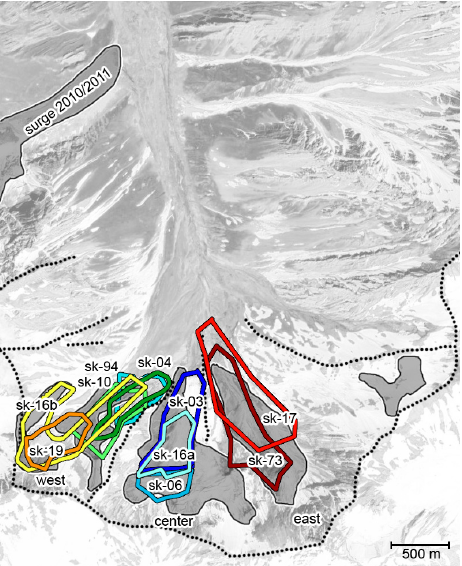
Figure 7. All release areas of ice masses in the Shuraki Ka- pali catchment overlap with the glacier outlines (gray shading) of the GLIMS database. Black dotted lines mark terrain ridges and separate sub-catchments. Background image from 19 July 2019 © Google, Maxar